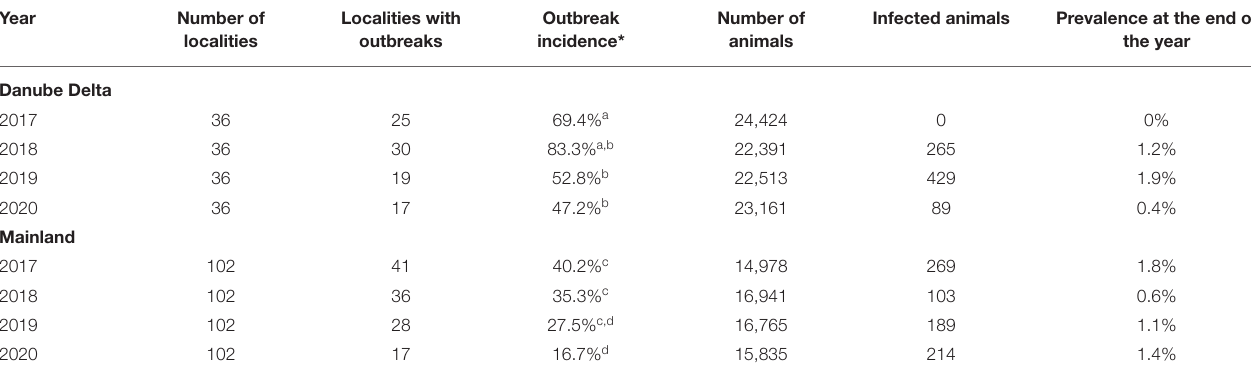
TABLE 1 | The outbreak situation of EBL in Tulcea County, Romania.